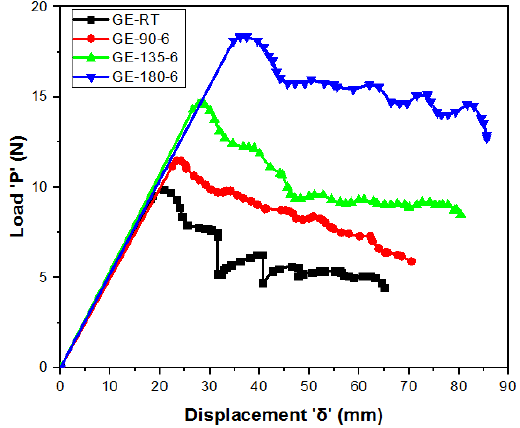
Figure 9. Load (P) versus Displacement (δ) plots from DCB tests of GE laminates.